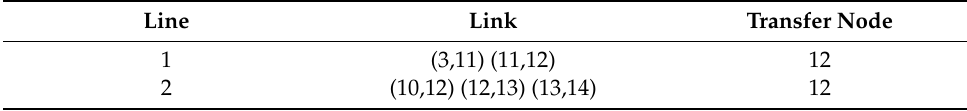
Figure 5. The routes of the rail transit network. Table 3. The information of rail transit routes. Line